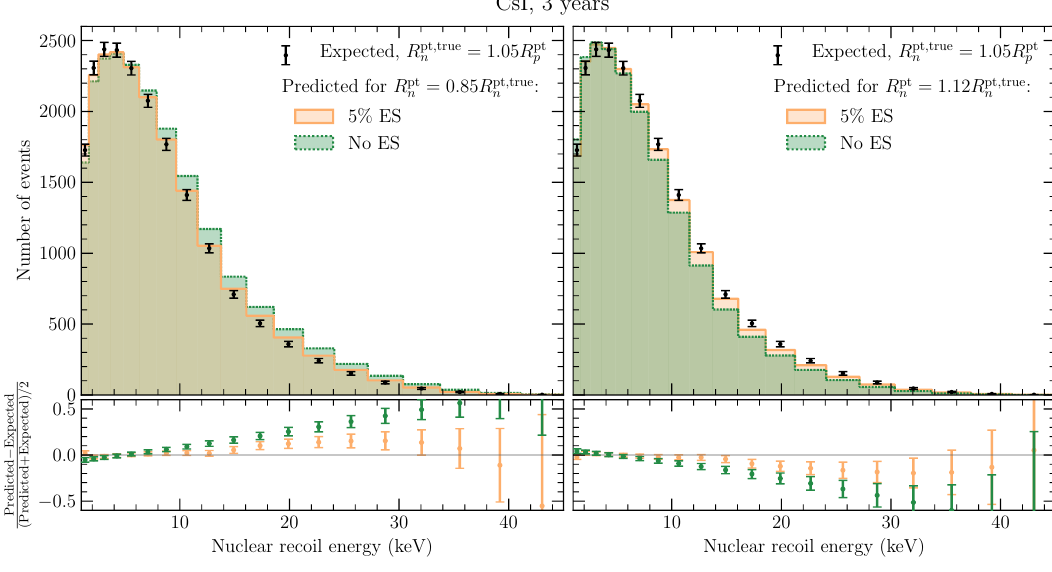
Figure 2 . Recoil energy spectrum of events in the cryogenic undoped CsI scintillator array. The data points correspond to the simulated data event rates for R pt ; true = 1 : 05 R p and the error n bars represent their statistical error. The colored histograms show the expected distributions for (right panel), with pulls chosen to optimize the (cid:12)t R pt = 0 : 85 R pt (left panel) and R pt = 1 : 12 R pt n p n p to the simulated data. The di(cid:11)erent histograms correspond to di(cid:11)erent assumptions of the energy scale systematic uncertainty (see text for details). The lower panels show the relative di(cid:11)erence in the event rates per bin, with error bars showing the corresponding